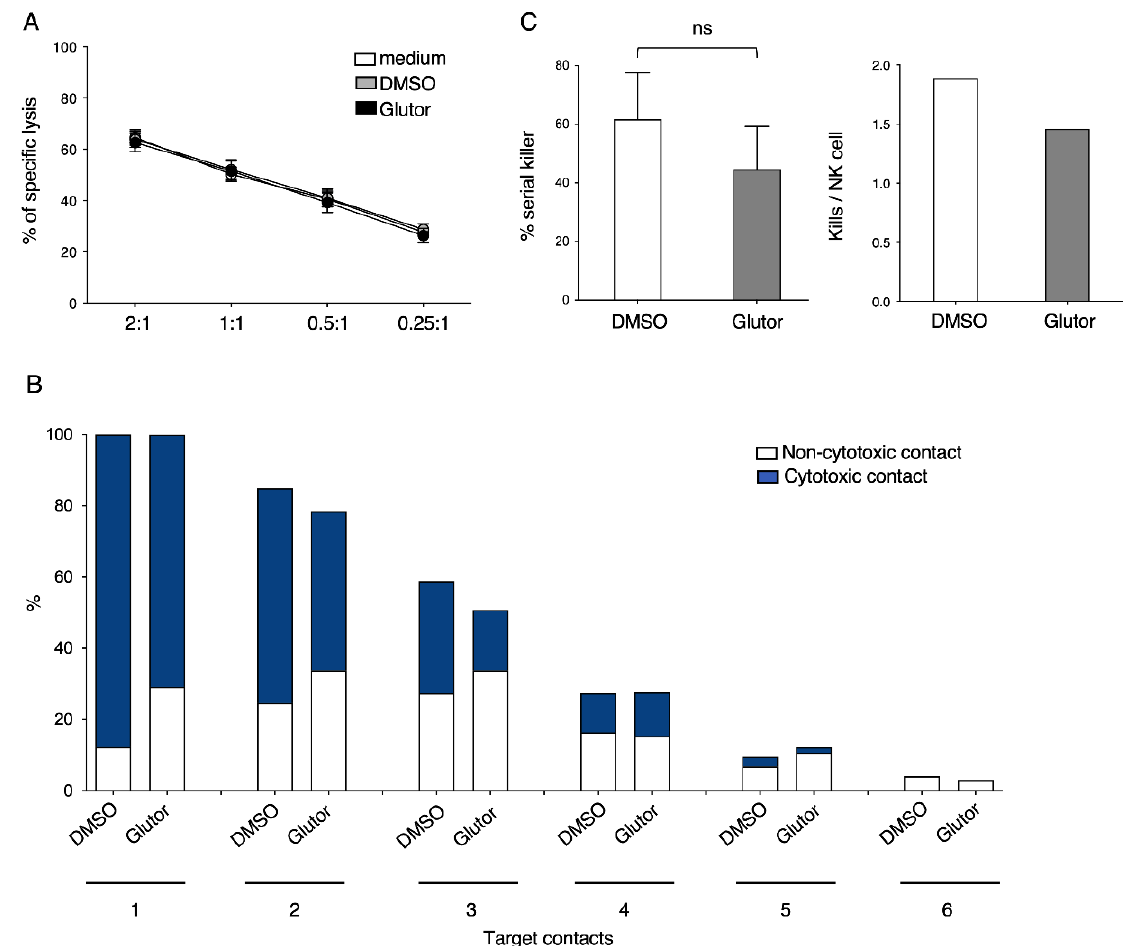
Figure 7. Serial killing capacity is not affected by Glutor. ( A ) Specific lysis of K562 using long-term treated NK cells (100 nM Glutor or 0.1% DMSO) in the continued presence of Glutor or DMSO was quantified using 51 chromium-release assay starting at an E:T of 2:1: n = 3. Data were pooled